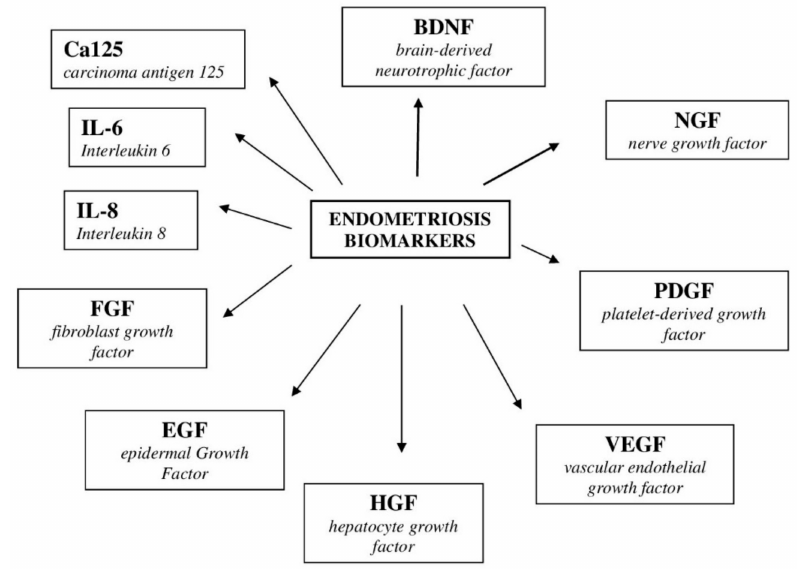
Figure 2. The potential endometriosis